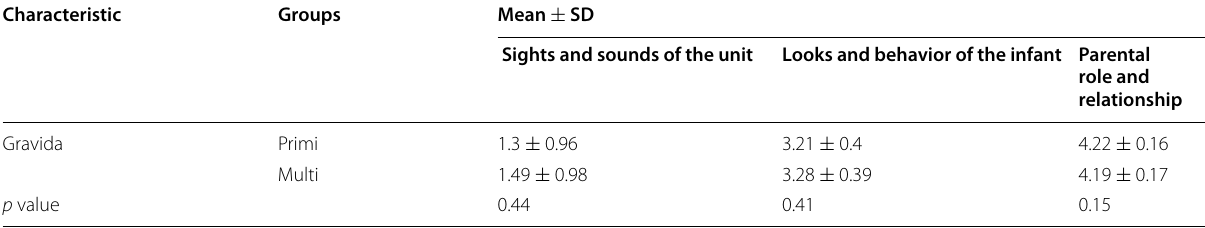
Table 2 Mean stress scores of individual domains in relation to gravida Characteristic